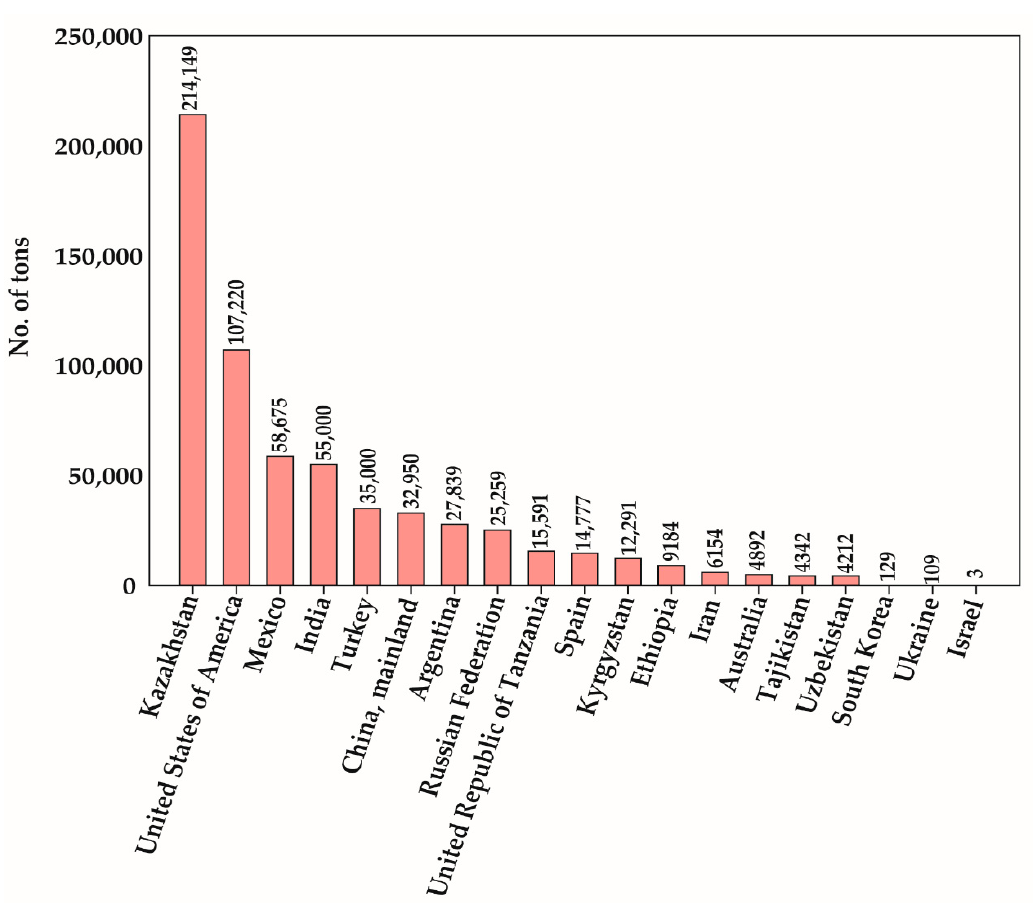
Figure 2. List of world’s top safflower-producing countries in 2018. The total number of tons of production value for each country is shown in the graph. The country-wise production statistics were obtained from FAOSTAT (2020) [9], while the production value of South Korea was obtained from the database of Ministry of Agriculture, Food and Rural Affairs, Korea.